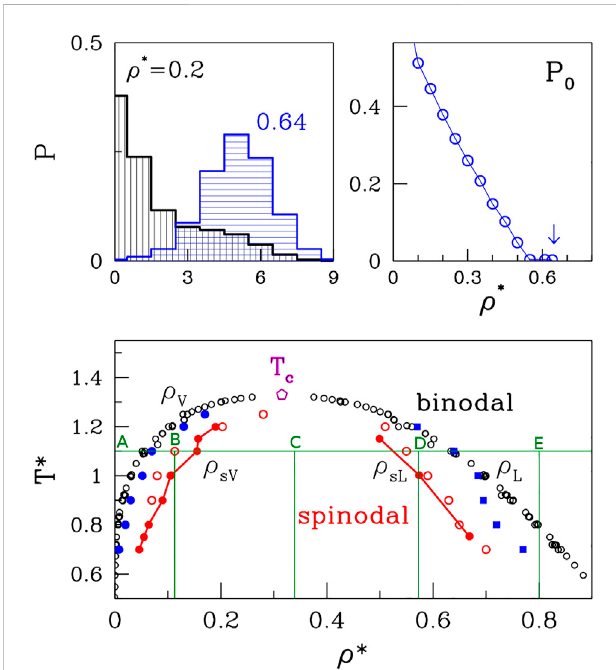
FIGURE 1 The bottom panel: The phase diagram of the van der Waals fl uid. The open black and solid red circles correspond to the binodal and spinodal lines, respectively and the data originate from a summary of simulations and experiments presented by Stephan et al. (2019). The open red circles on the right of the graph represent the upper density spinodal line obtained based on the average cluster size analysis. The open red circles on the left of the graph represent low-density side and they point to the location of the left side of the spinodal line. The blue squares represent the high density binodal line based on the cubes occupancy analysis, and the blue circles represent low density binodal line. The green lines mark the densites at which the different phases are presented in Figure 5. The T C marks the critical temperature. The top panels: The method of ρ L determination based on the occupancy of small bins